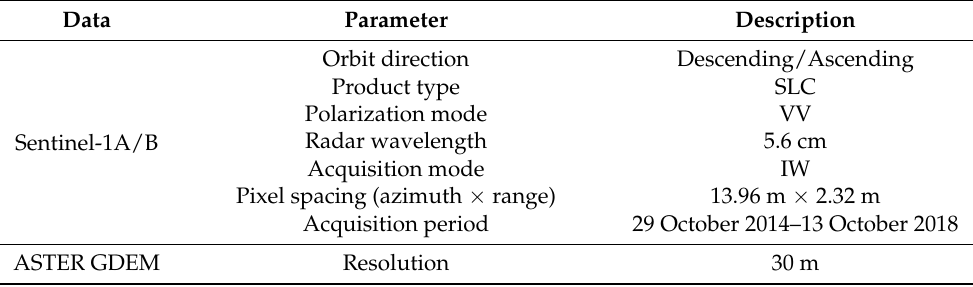
Table 1. Specific parameter information related to Sentinel-1A/B SAR images and ASTER GDEM data.